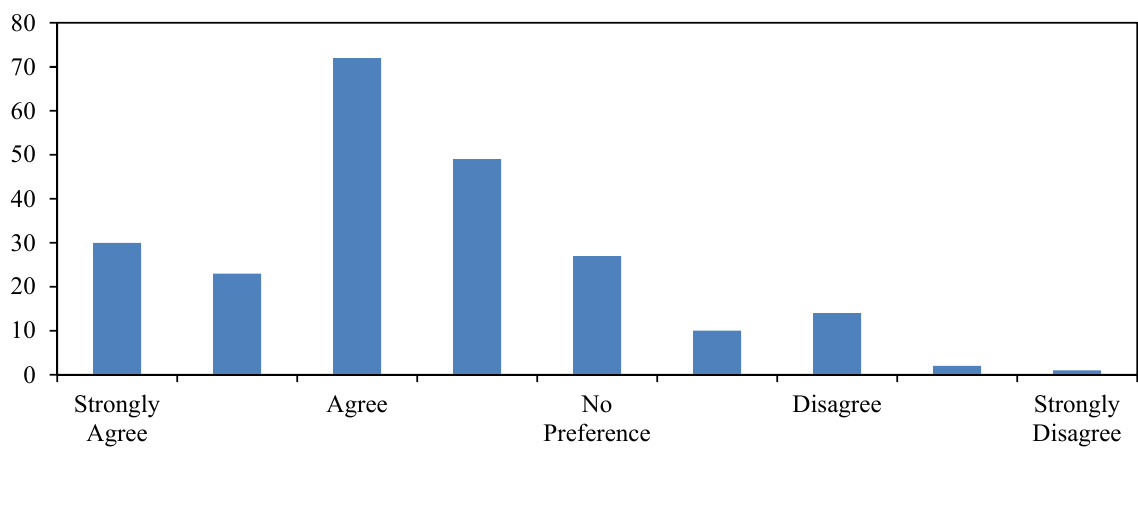
Figure 8. Graph of responses to the statement “I would trust a computer analysis of data if the software had been reviewed by a panel of trusted experts”.